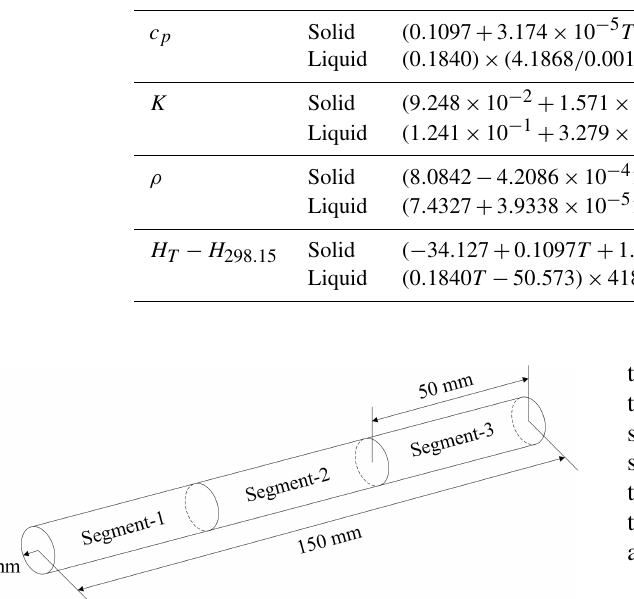
Figure 4. Schematic drawing of the 3D model geometry used in commercial